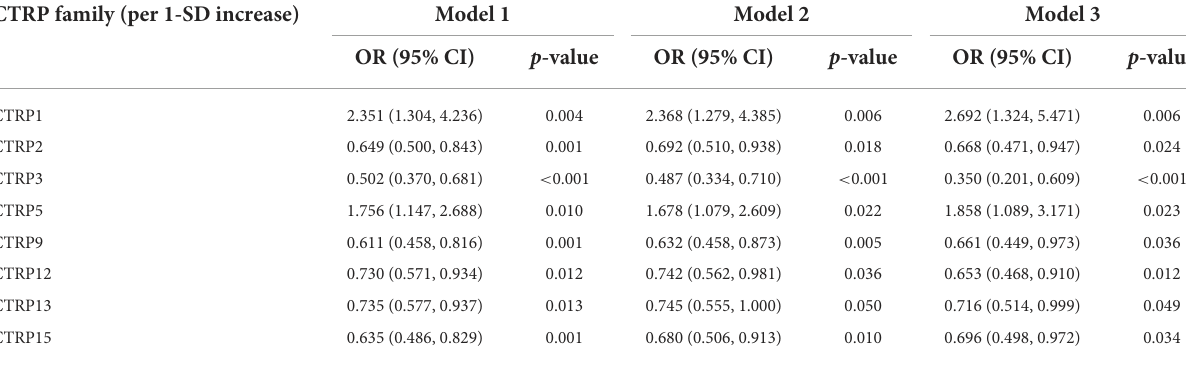
TABLE 3 Univariate and multivariate logistic regression analyses of ACS risks according to 1-SD increasing of serum CTRP family